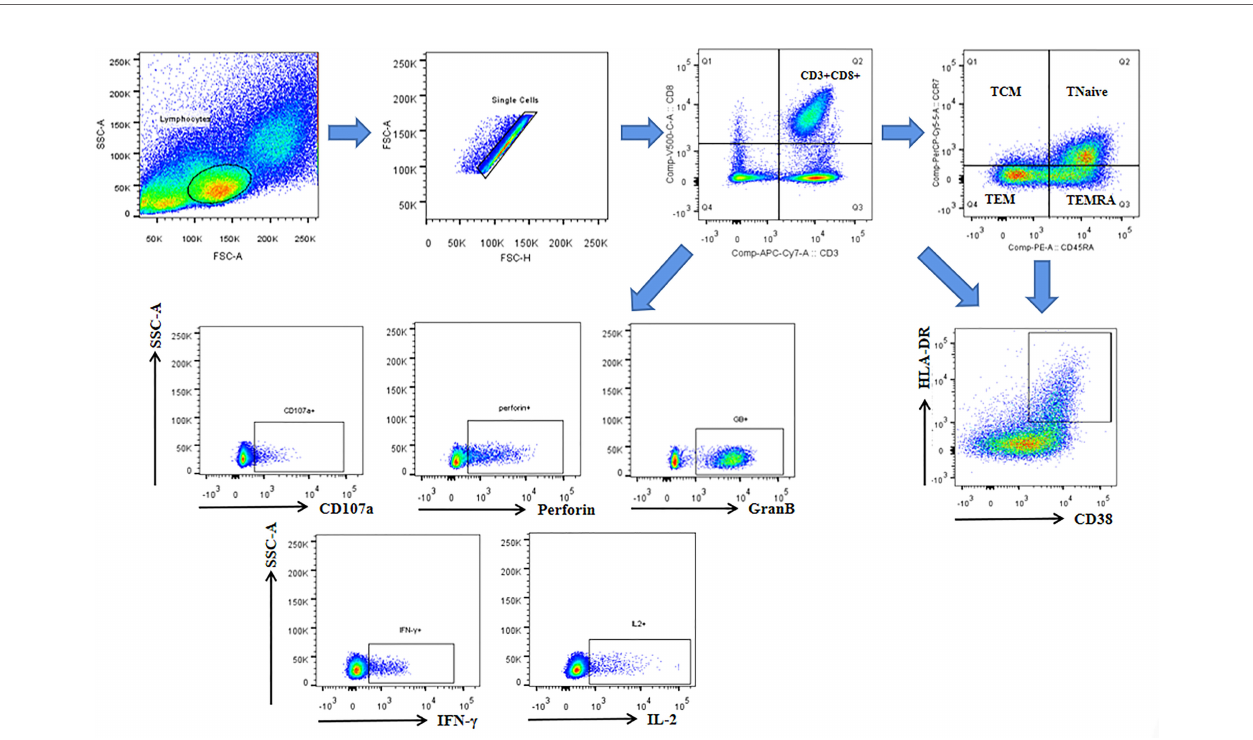
FIGURE 2 | The gating strategy of CD8 + T cells populations and other markers. Lymphocytes and single cells were gated fi rst. Then CD3 + CD8 + cells were gated. Central memory (TCM: CD45RA - CCR7 + ), Tnaive (CD45RA + CCR7 + ), effector memory (TEM: CD45RA - CCR7 - ), and terminally differentiated effector (TEMRA: CD45RA + CCR7 - ) subsets were gated based on gated CD8 + cells. CD38 and HLA-DR were gated based on gated CD8 + cells and each subsets. CD107a, perforin, GranB, IFN- g and IL-2 were gated based on gated CD8 +